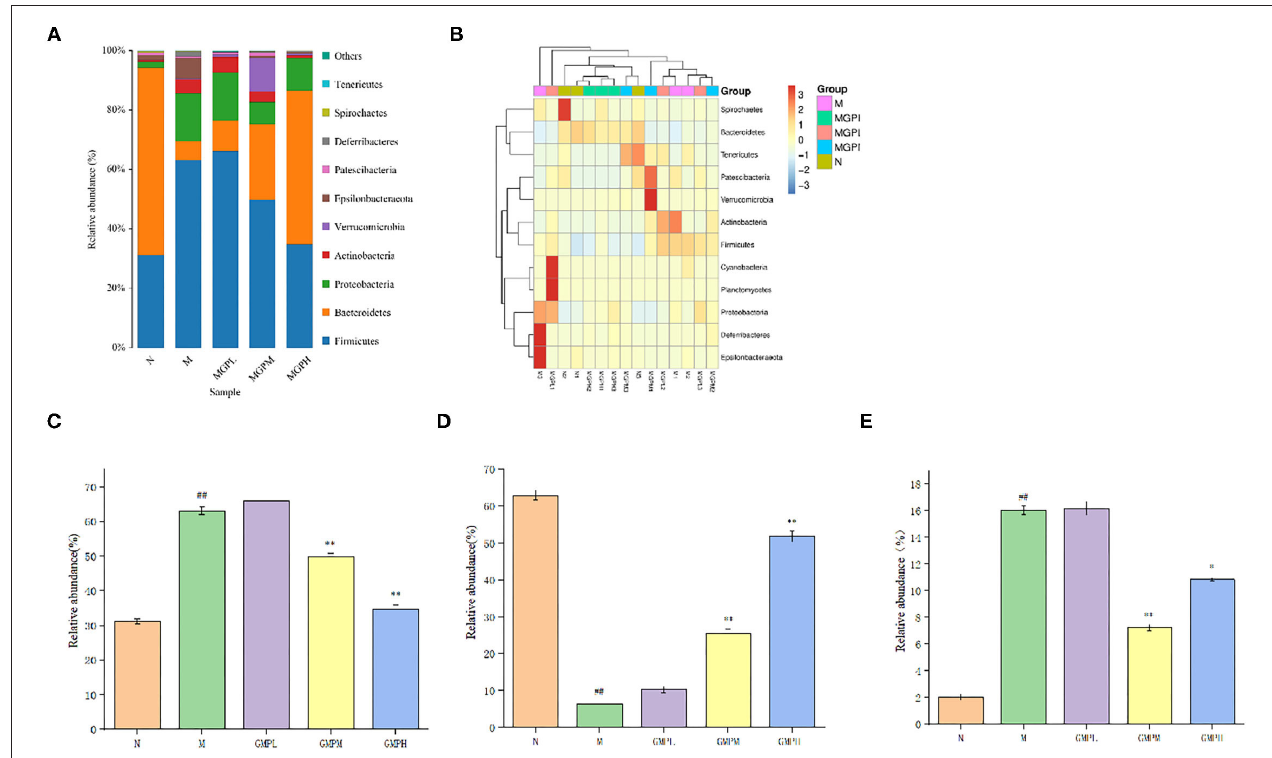
FIGURE 8 | Analysis of phylum level of intestinal flora in mice. (A) Phylum level species distribution. (B) Heat map of species distribution at the gate level. (C) Firmicutes. (D) Bacteroidetes. (E) Proteobacteria. Significance of difference: *means p < 0.05, **means p < 0.001, compared with group M. ## means p < 0.001, compared with group